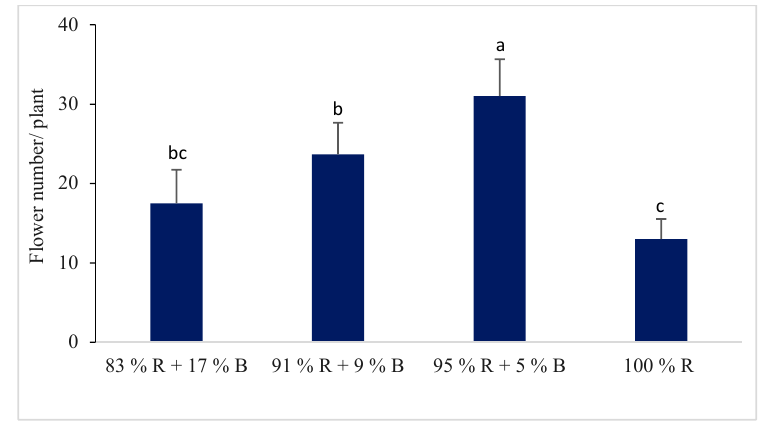
Figure 2. The effect of different percentages of red (R) and blue (B) LEDs on the initiation of the flowering of the sweet pepper. Bars represent the standard deviation (n = 6). Values with different letters are significantly different from each other ( p < 0.05).